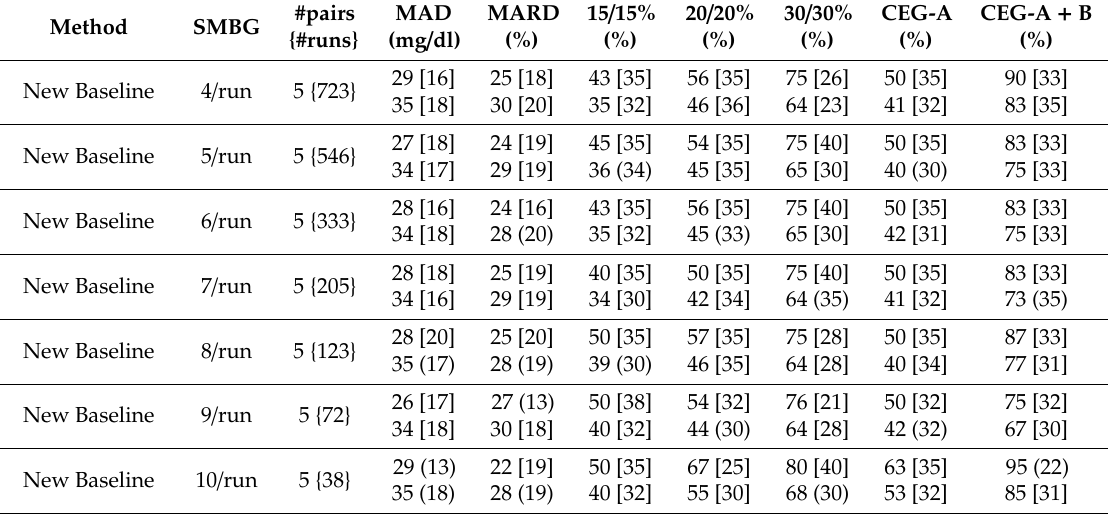
Table 3. Performance metrics as median [interquartile range] or mean (standard